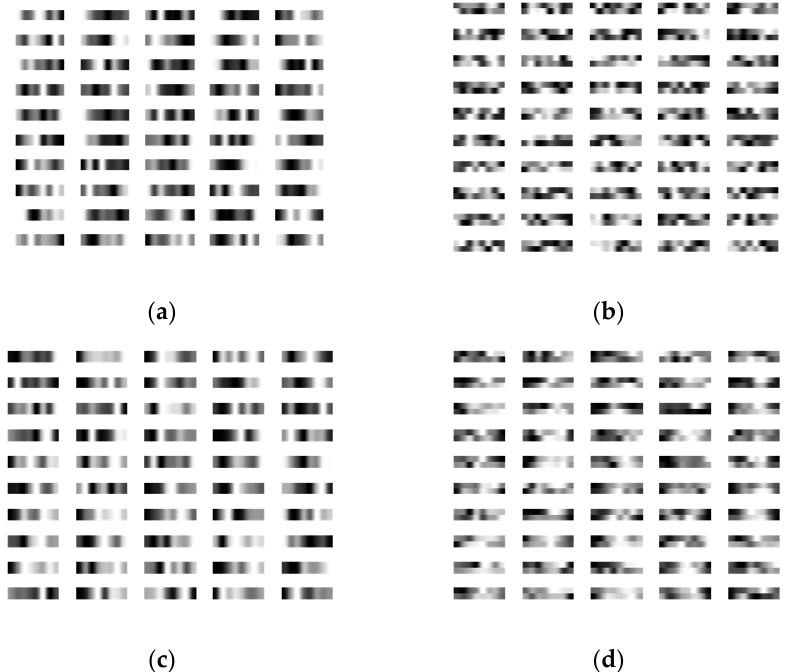
Figure 6. Visualization of the convolution kernels of ( a ) Conv 2-IA, ( b ) Conv 2-IB, ( c ) Conv 2-IIA, and ( d ) Conv 2-IIB in HMF.